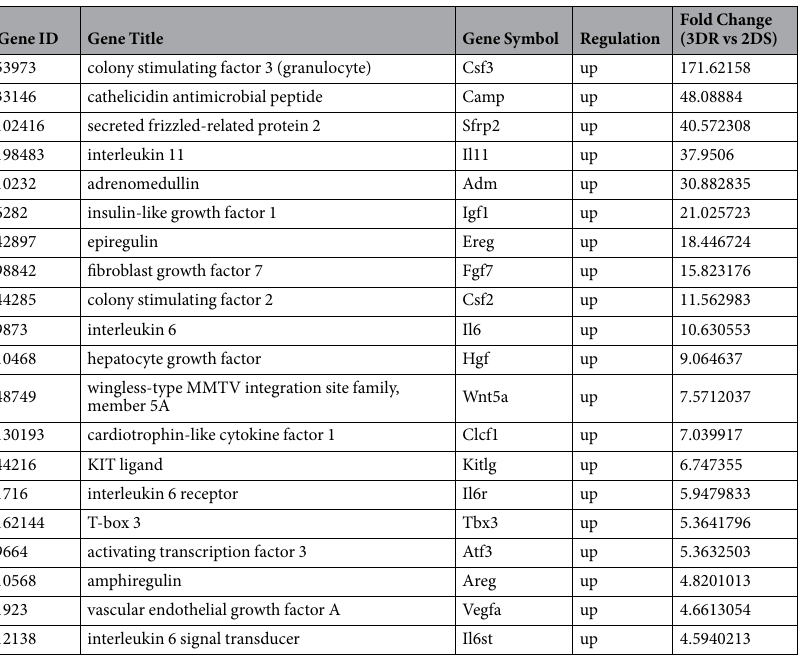
Table 1. Top 20 up-regulation gene expression of positive regulation of cell proliferation in biological process